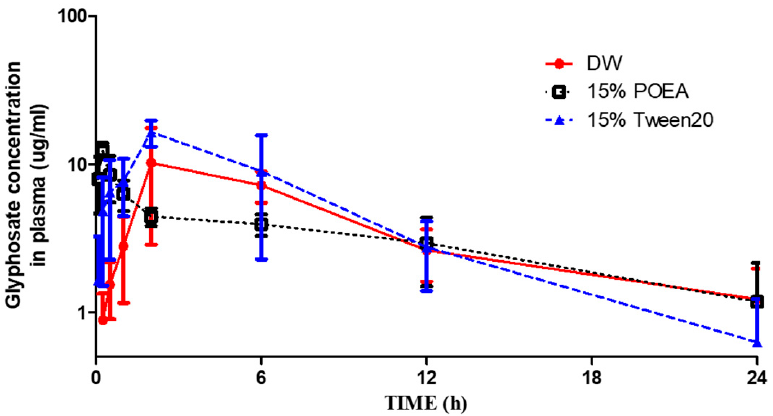
Figure 1. Average plasma concentration–time profiles of glyphosate in DW, 15% POEA and 15% Tween 20 groups to rats (50 mg/kg, P.O.) ( n = 5). Table 2. Toxicokinetic parameters of glyphosate following oral administration at dose of 50 mg/kg to rats.